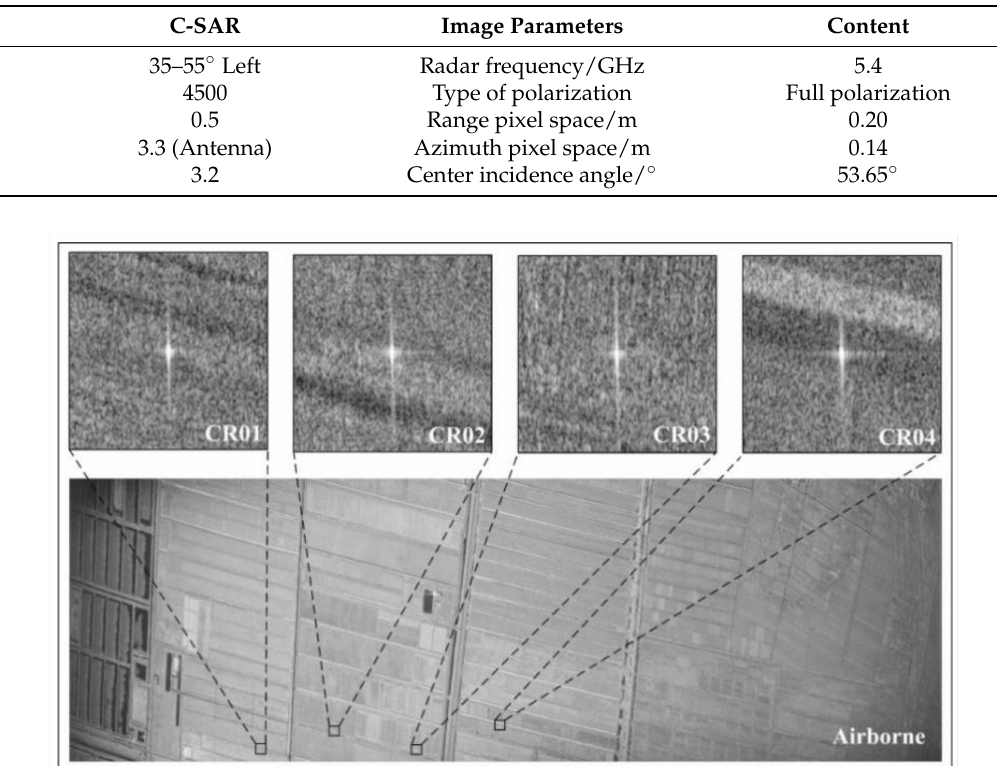
Table 2. C-band microwave loading experiment and SLC image parameters.